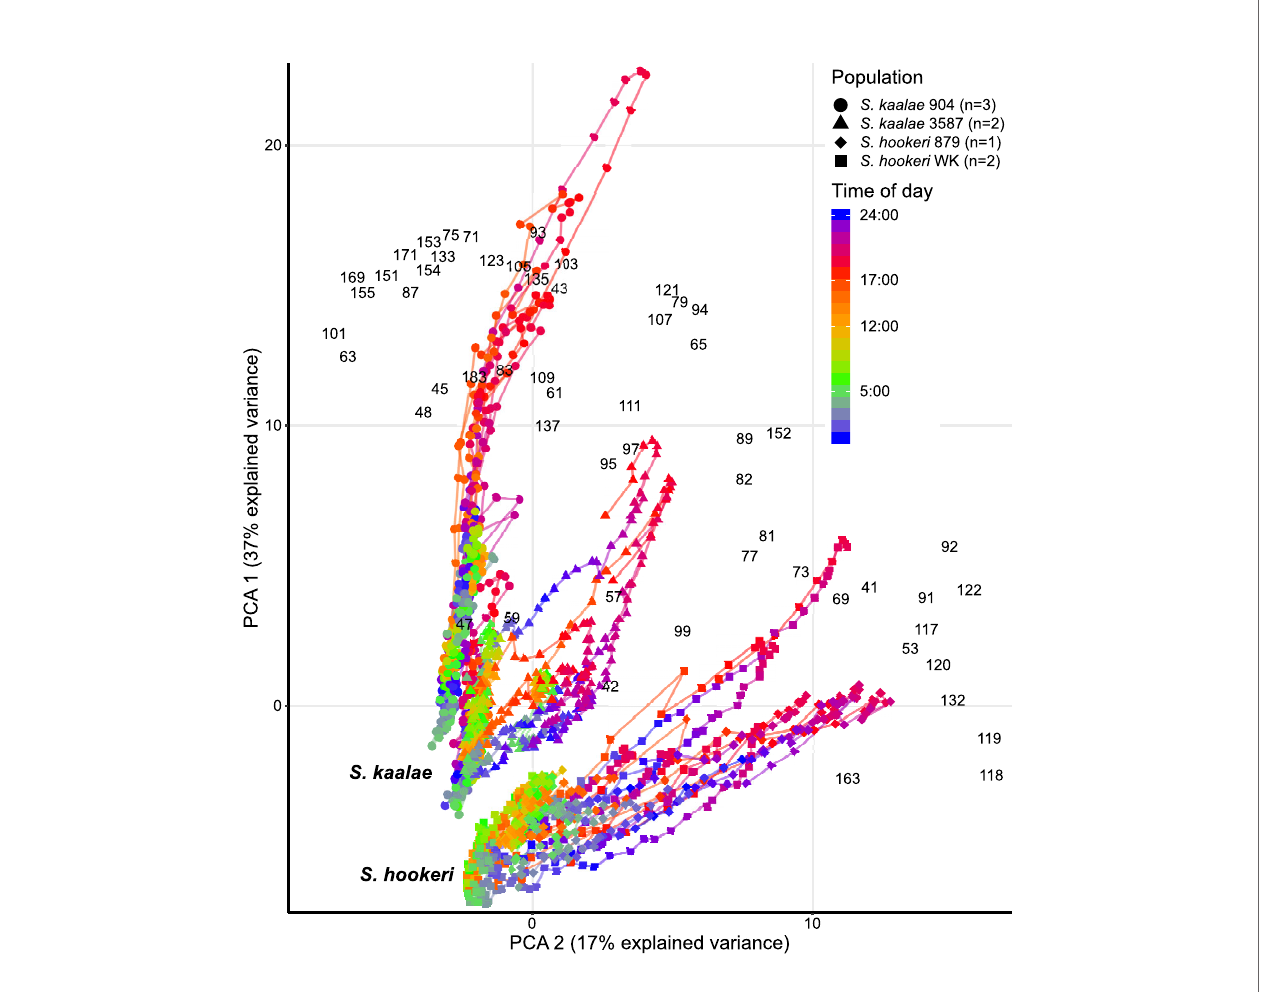
FIGURE 3 | Daily patterns of fl oral scent in the same fi ve Schiedea kaalae plants and three S. hookeri plants as in Figure 2 mapped by principal components analysis (PCA) of PTR-MS ion signals with maxima over 0.001 counts·s -1 · fl ower -1 , including unidenti fi ed ions. The fi rst and second principal components are shown on the vertical and horizontal axes. Loadings for each ion are indicated by the black m/z numbers ( Supplementary Table S3 ). Lines connect adjacent time points for each plant. Time of day is represented by different colors on the line, with transitions from dark to light at 5:00 (cyan-green) and light to dark at 17:00 (orange-red) marked on the scale. The source population (904, 3587, 879, WK) is indicated by the shape of the points (collection locations in Supplementary Table S1 ). Each plant was sampled for 2 – 4